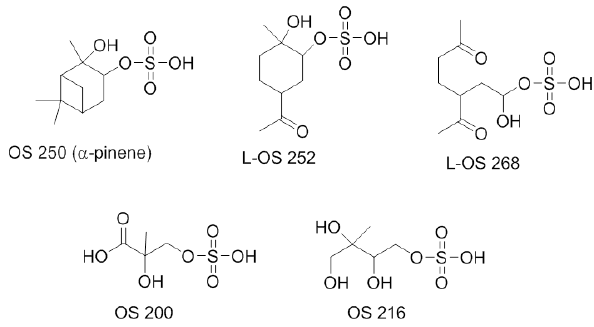
Figure 10. Selected organosulfates derived from monoterpenes and isoprene (Surratt et al., 2007, 2008). Note that isomers are possible for the given